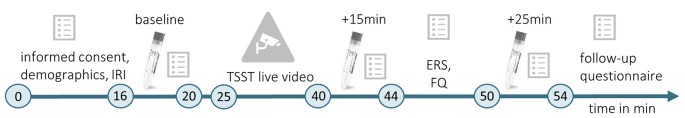
Timeline of Experiment 2. During the initial habituation phase (min 0–16), participants gave informed consent, completed a demographic questionnaire and the IRI (German version; Paulus, 2009). Then, the first baseline measurement of the physiological and psychological stress indices was conducted (baseline, min 16–20). The committee for the TSST (Kirschbaum et al., 1993) entered the testing room where the male target was seated, the live video was started and TSST instructions were delivered (min 20–25). The TSST (min 25–40) was followed by a second measurement of physiological and psychological stress indicators (min 40–44), which took place 15 min after the beginning of the video. Subsequently, the ERS (Batson et al., 1997) and a self-developed familiarity questionnaire (FQ) were completed (min 44–50). The last stress measurement (min 50–54) took place 25 min after the beginning of the TSST live video (+25 min). For male targets and female observers, the experiment followed the same timeline. However, male targets did not complete the IRI, ERS, and FQ. In the end, female observers completed a follow-up questionnaire.